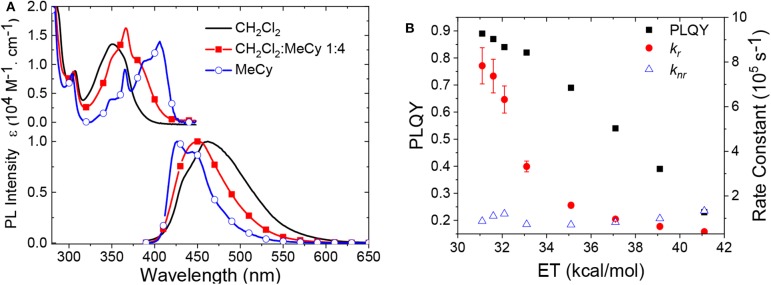
(A) Absorption and emission spectra of AuBZI in CH2Cl2, MeCy, and a mixture of both solvents. (B) Change in ΦPL and radiative and non-radiative rate constants of AuBZI as a function of solvent polarity.